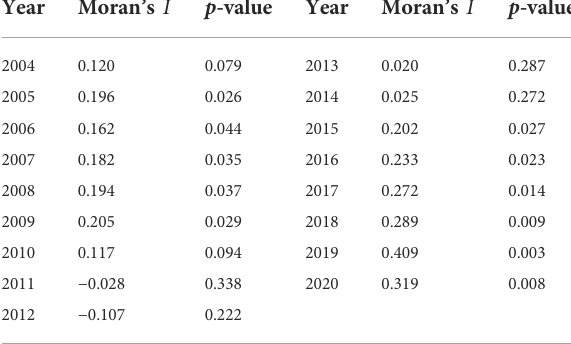
TABLE 3 Global Moran ’ s I test